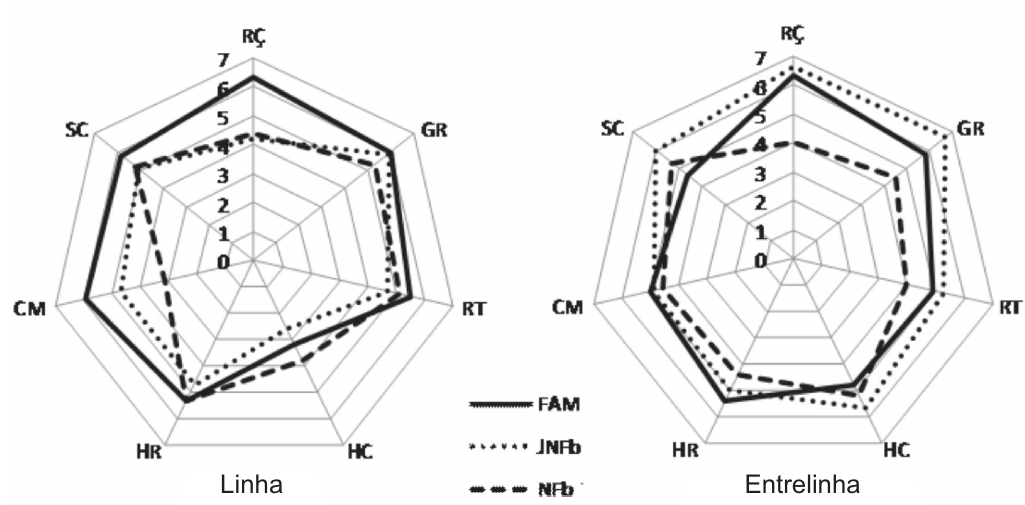
Figura 1. Diagrama radar apresentando a densidade (log NMP g -1 de solo) de microrganismos diazotróficos não simbióticos, isolados nos meios FAM, JNFb e NFb, na linha e entrelinha do cafeeiro em estudo. Métodos de controle de plantas daninhas: roçadora (RÇ), grade (GR), enxada rotativa (RT), herbicida pós-emergência (HC), herbicida pré-emergência (HR), capina manual (CM) e sem capina